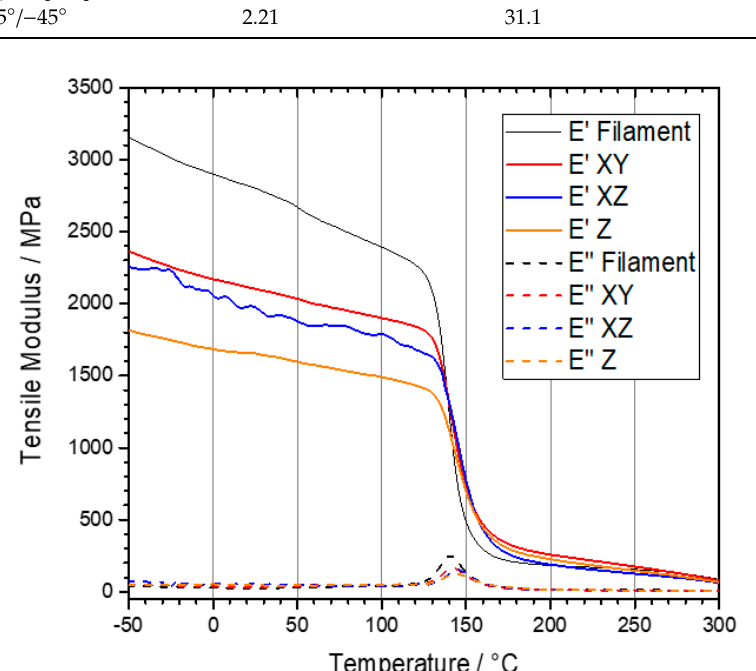
Figure 5. Storage and loss moduli of PEEK filament and 3D printed samples with a − 45/+45 raster layer orientation [112].